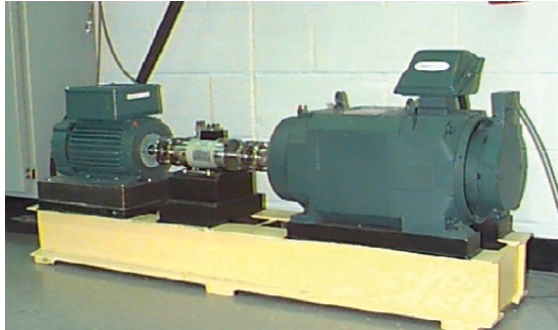
Figure 9: Test platform of Case Western Reserve University. Table 1: Structural parameters of SKF6023-2RS. Ball diameter Pitch diameter Ball number Contact angle